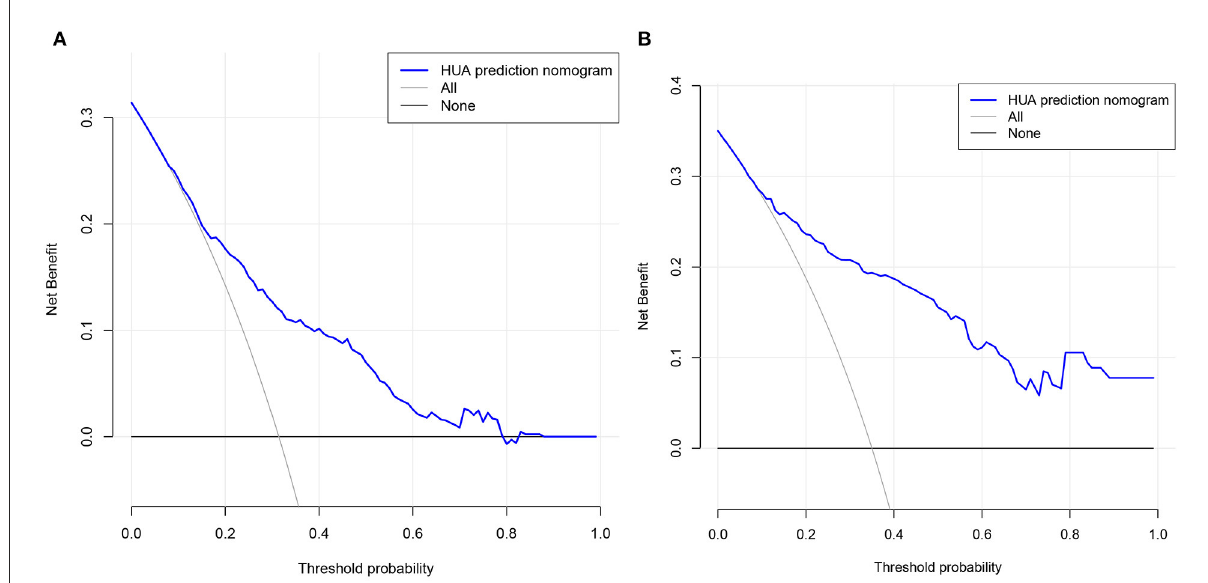
FIGURE6 Decision curve analysis. (A) Training cohort and (B) validation cohort. The black line represents the net benefit when none of the participants are considered to develop HUA, while the light gray line represents the net benefit when all participants are considered to develop HUA. The area between the blue line and light gray line in the model curve indicates the clinical utility of the